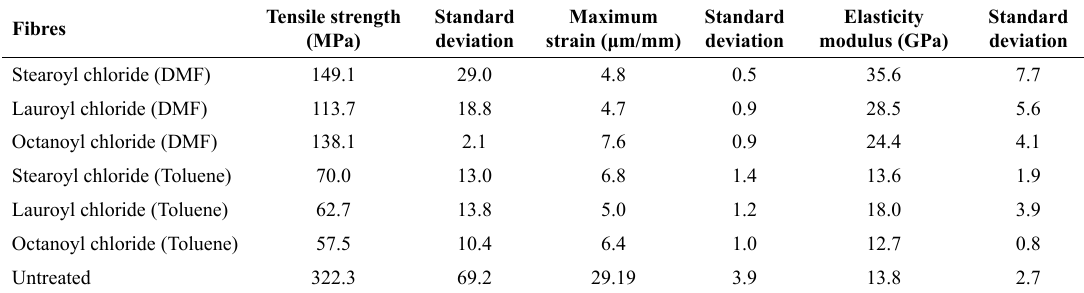
Table 5. Average results of tensile tests of the fibres. Fibres